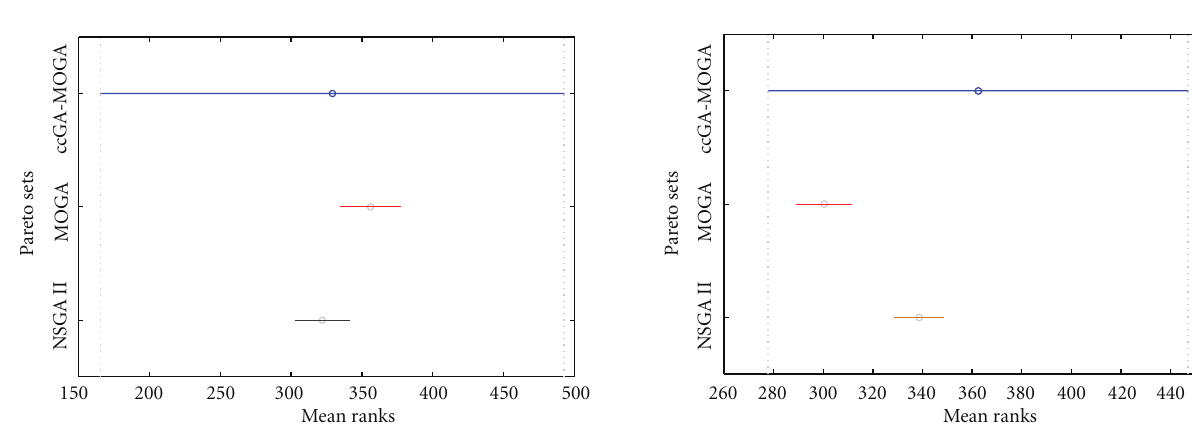
Figure 8: Final crop number box plots from the ccGA-MOGA, MOGA, and NSGA II Pareto sets.